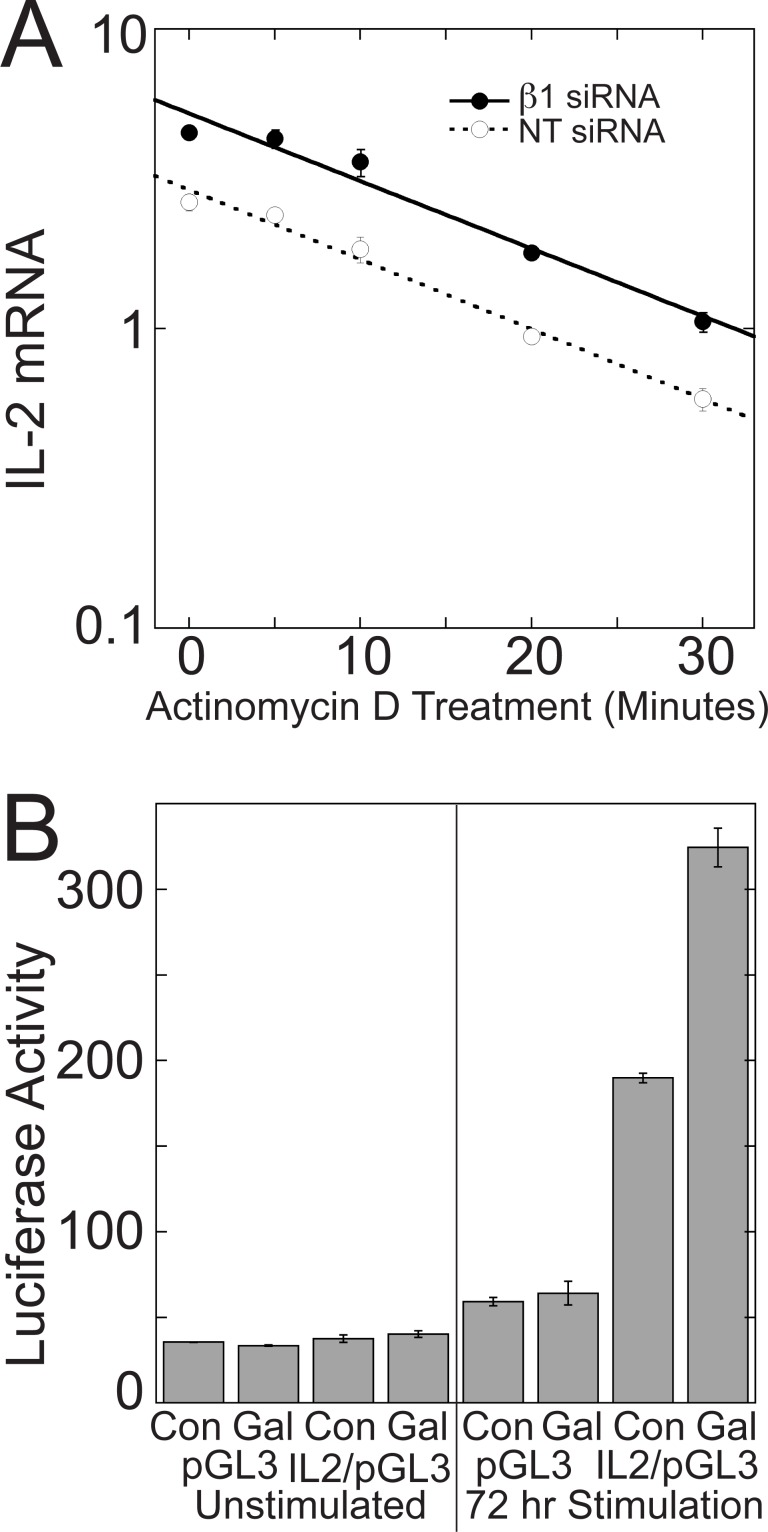
Disrupting Gβγ signaling enhances TCR-stimulated IL-2 transcription without affecting IL-2 mRNA stability.(A) Gβ1 siRNA does not increase stability of IL-2 mRNA. After three days of TCR stimulation with plate-bound anti-CD3 and soluble anti-CD28 and treatment with Gβ1 siRNA or NT siRNA, Jurkat cells were incubated for the indicated times with 10 μg/mL of Actinomycin D to inhibit transcription, and the rate of IL-2 mRNA degradation was measured. In both cases, the rates of IL-2 mRNA degradation fit a single exponential. Data represent means ± SD from triplicate determinations from a single experiment representative of 5 experiments. (B) Gallein increases IL-2 promoter activity in a luciferase reporter assay. Jurkat cells were stimulated with plate-bound anti-CD3 and soluble anti-CD28 in the presence or absence of gallein for three days following nucleofection with the indicated plasmids. Data represent means ± SD from triplicate determinations from a single assay representative of 8 assays.